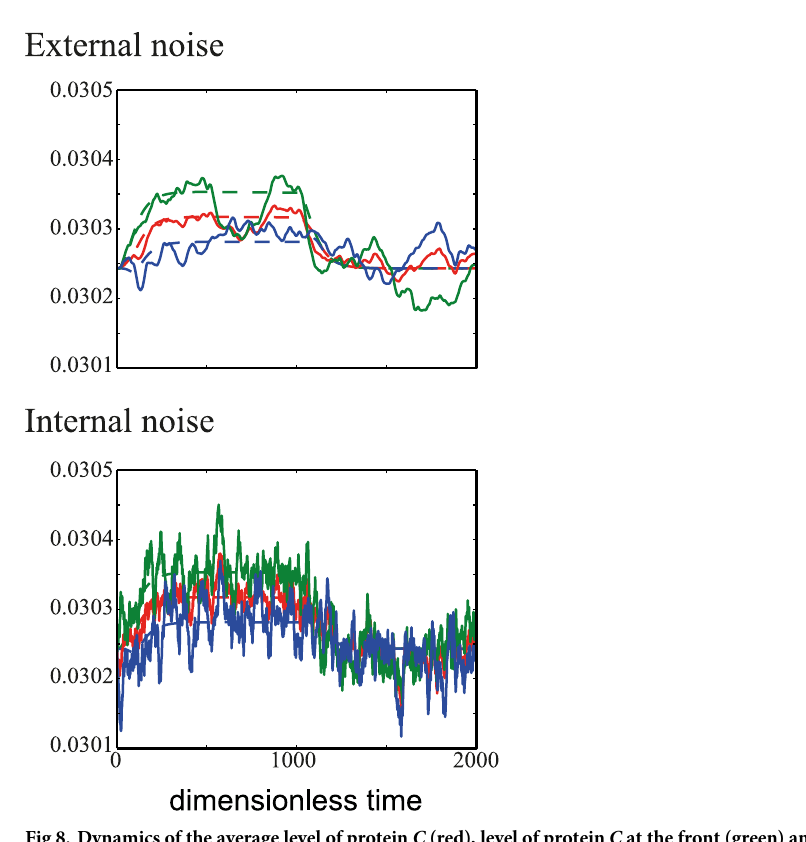
¼ 1 : 0 , D 0 ¼ 100 : 0 and η = 1.0 (top) A B